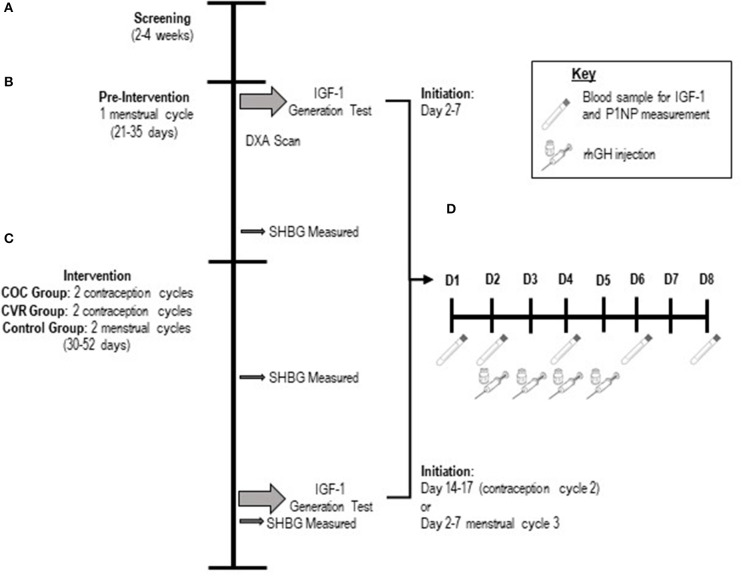
Schematic of the study design. (A) Screening lasted 2–4 weeks. (B) The pre-intervention phase was one menstrual cycle in duration. (C) The intervention phase was two contraception cycles or menstrual cycles in duration. (D) Schematic of the 8-day protocol for the IGF-I Generation Test. Participants had rhGH injections subcutaneously on days 2–5 of the 8-day protocol. Blood samples were taken from participants on days 1,2,4,6, and 8 of the 8-day protocol. COC, combined oral contraception; CVR, contraceptive vaginal ring; DXA, dual x-ray absorptiometry; rhGH, recombinant human growth hormone.